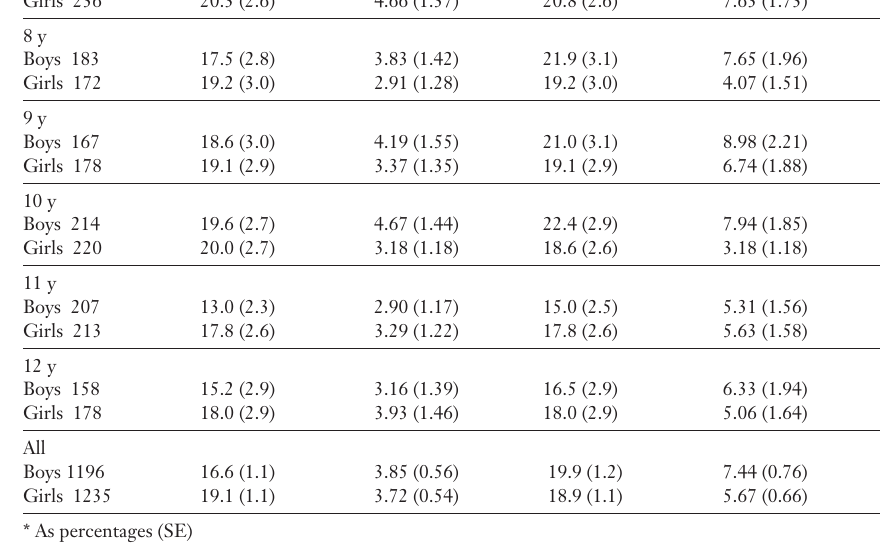
Table 2 The prevalence* of overweight and obesity in a national sample of 6–12 year old Swiss children (n = 2431) by age and gender using the IOTF [12] and CDC [13] BMI reference criteria.